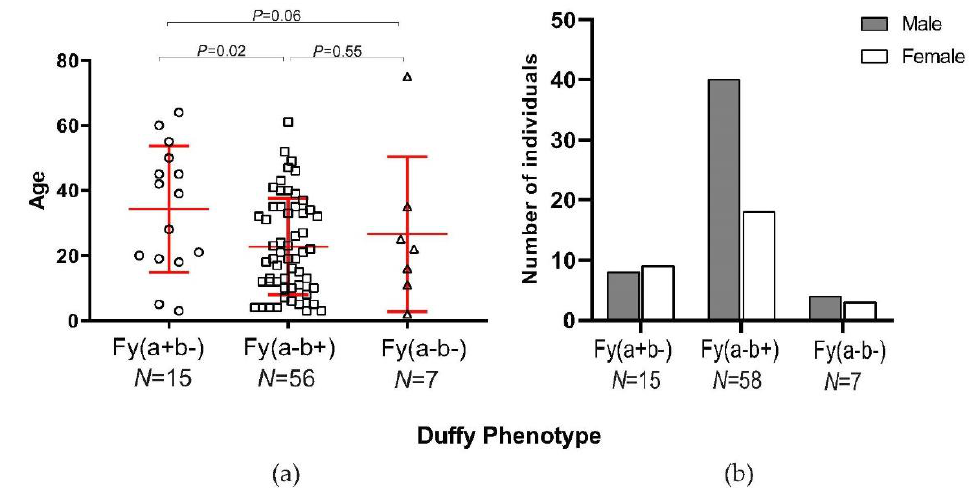
Figure 3. ( a ) Distribution of age of patient in years among the different phenotypes in Plasmodium positive patients; ( b ) proportion of male and female Plasmodium -positive patients between the different Duffy phenotypes. It is noted that there were two patient samples that we did not have their age data for. Thus, the sample size in Fy(a-b+) was different.